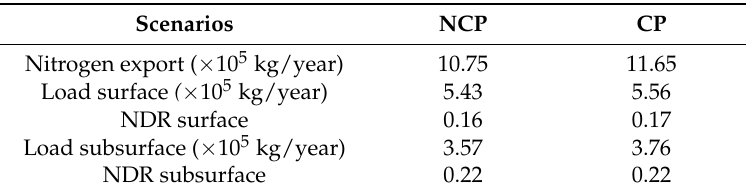
Table 2. The value of variables in the NDR (Nutrient Delivery and Retention)